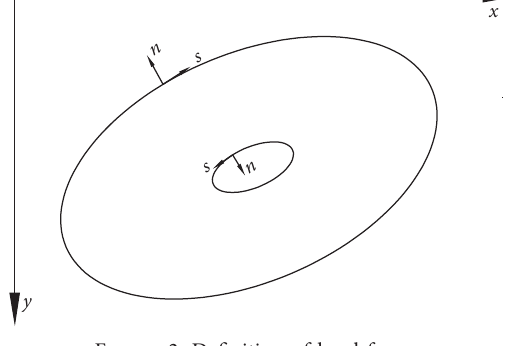
Figure 2: Definition of local